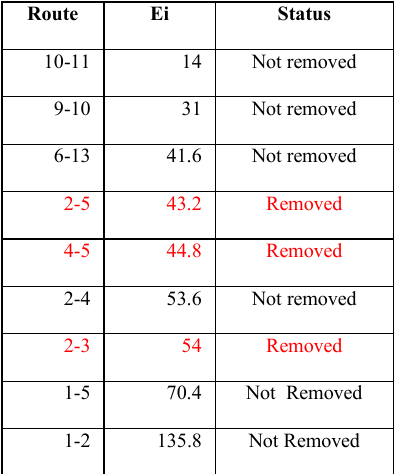
Fig7.Economic index after exclusion of less efficient line